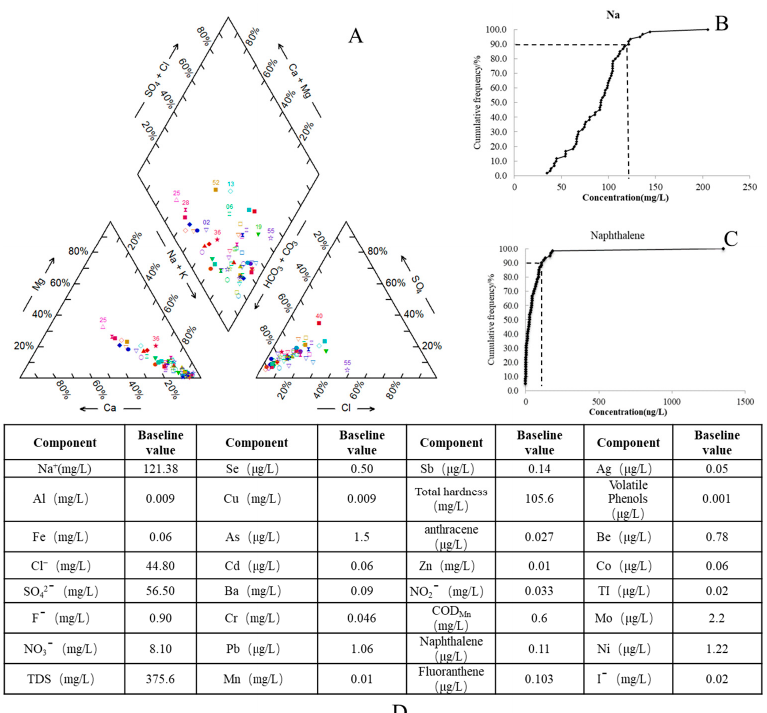
Figure 5. The baseline levels of natural components. ( A ) The hydrochemistry of groundwater in the study area; ( B ) The frequency of Na + accumulation; ( C ) The frequency of Nap accumulation; ( D ) The baseline levels of natural components.